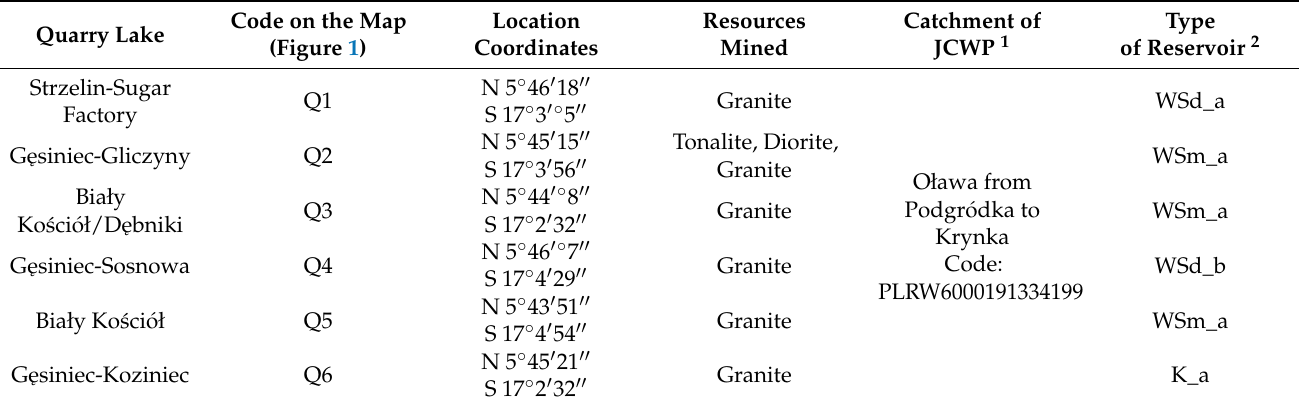
Table 1. Characteristics of the analysed quarry lakes (author B.J.).